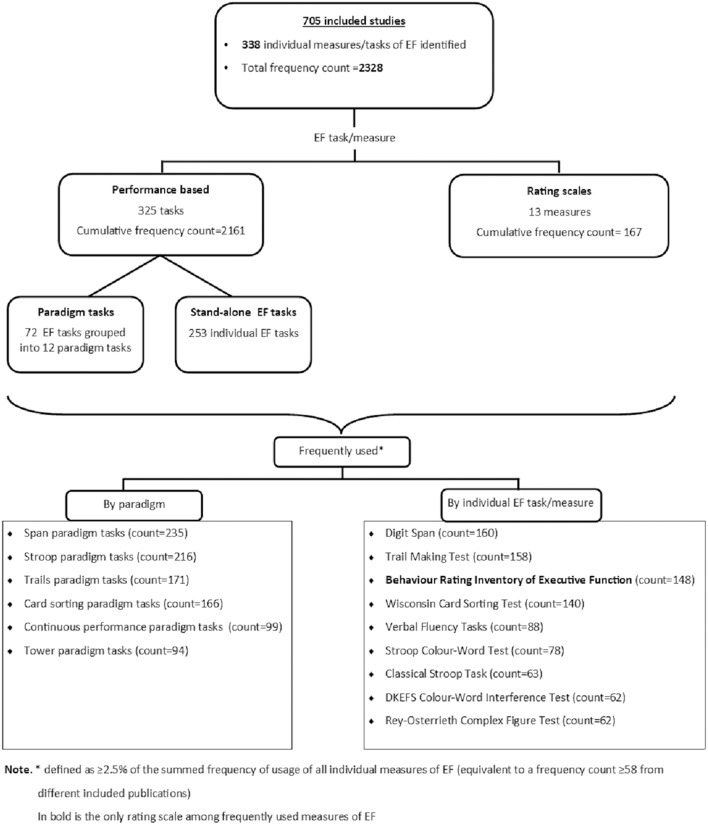
Categorization of identified measures of EF.